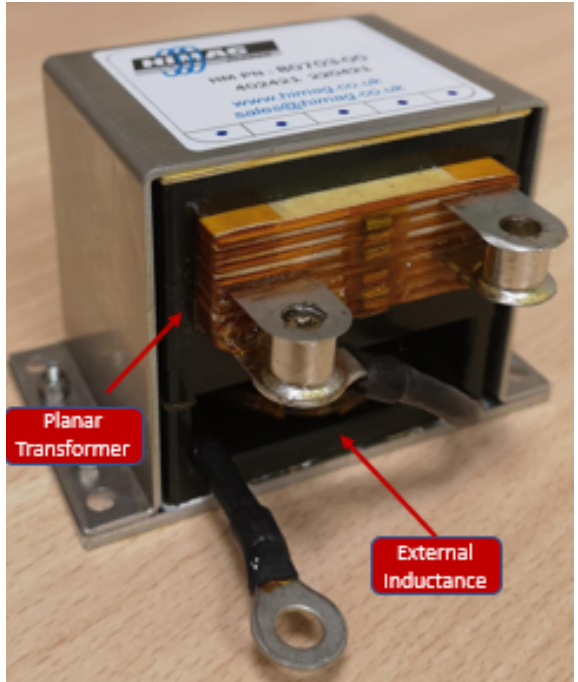
Figure 7. Planar transformer with external power inductor. Table 5. Planar transformer